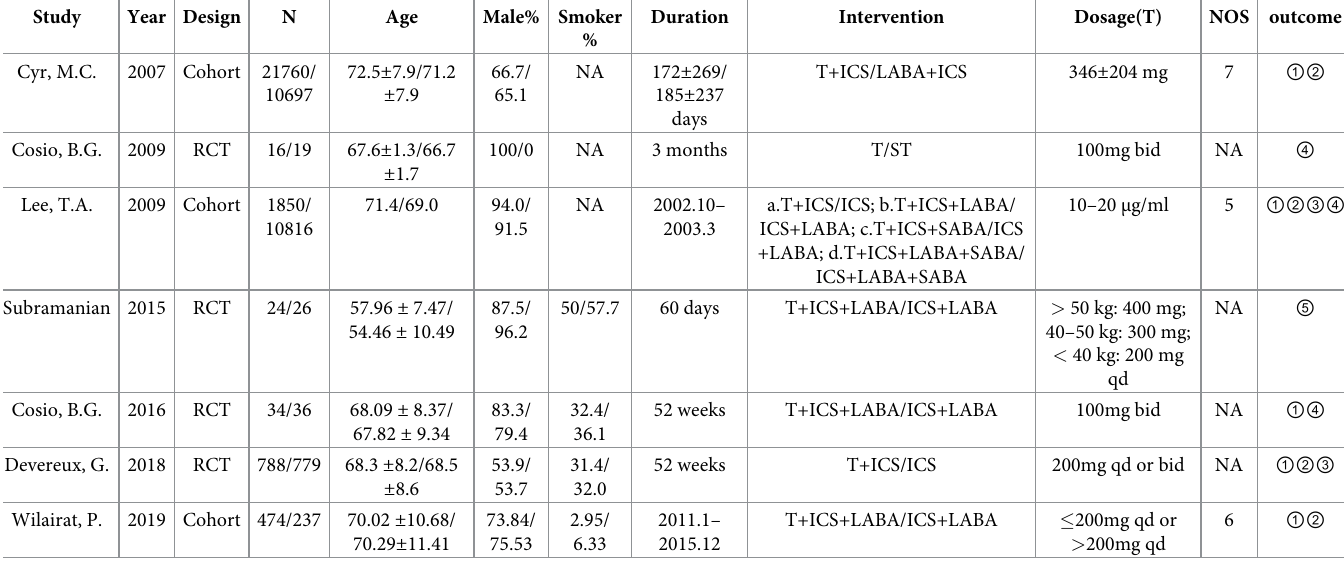
Table 1. Characteristic of included studies (n = 7).